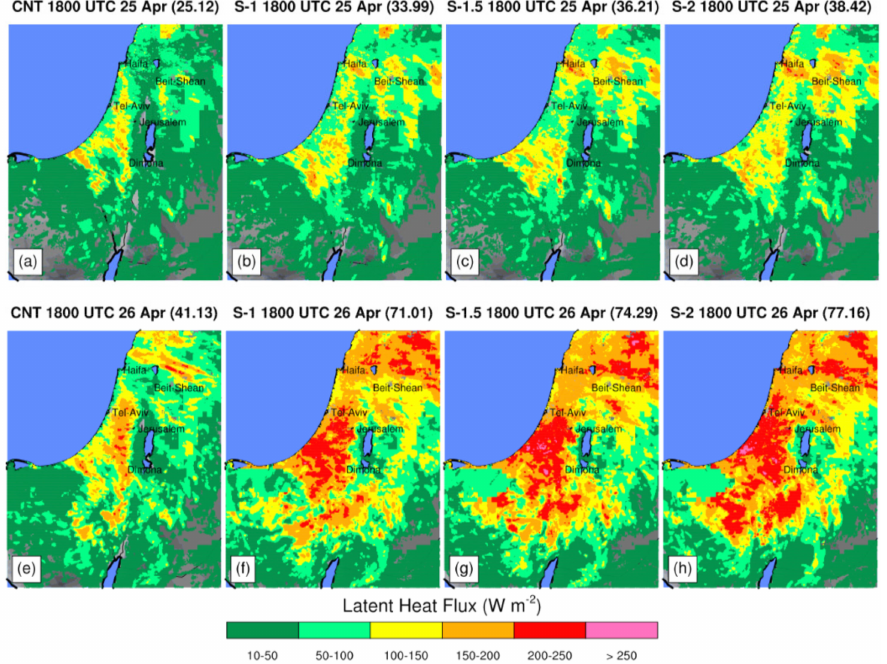
Figure 8. Simulated latent heat from forecasts with GFS initial volumetric soil moisture and those with derived soil moisture values based on radar observations. S-1 used the derived precipitation in 10 min intervals. S-1.5 and S-2.0 used 50 and 100% higher rainfall amounts (twice multiplied). Values were averaged from 0600 to 1800 UTC 25 April 2018 ( a – d ), and 26 April 2018 ( e – h ). The area average of latent heat flux over land is given in the map label within parentheses.